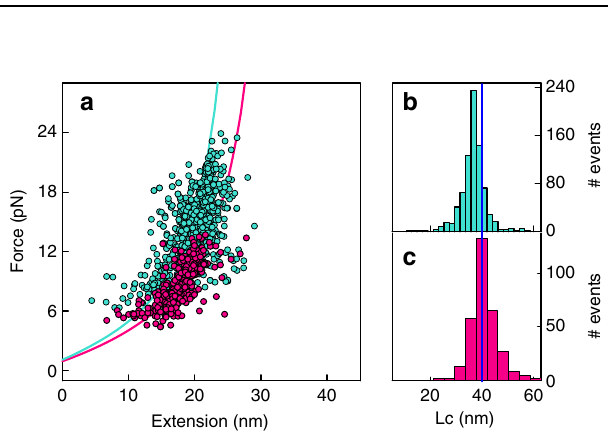
Fig. 3 Force extension events for Arc-L1-Arc. a Plot of unfolding force vs. resulting extension events for molecules that unfold and refold at high forces (802 events, turquoise) and at low forces (287 events, magenta). The magenta and turquoise lines represent the WLC function calculated using L c of 40.1 and 37 nm, respectively, and a persistent length of 0.65nm. Right. Contour length distribution for Arc-L1-Arc molecules that unfold/ refold at high b and low c forces. The blue line indicates the average L c obtained for Arc-L1-Arc molecules than unfolds/refolds at low forces. Note that the average contour length for molecules that unfold/refold at higher force (36.9 ± 2.8 nm) is signi fi cantly shorter ( p < 0.01) than that for molecules that unfold/refold at lower force (40.2 ± 3.8